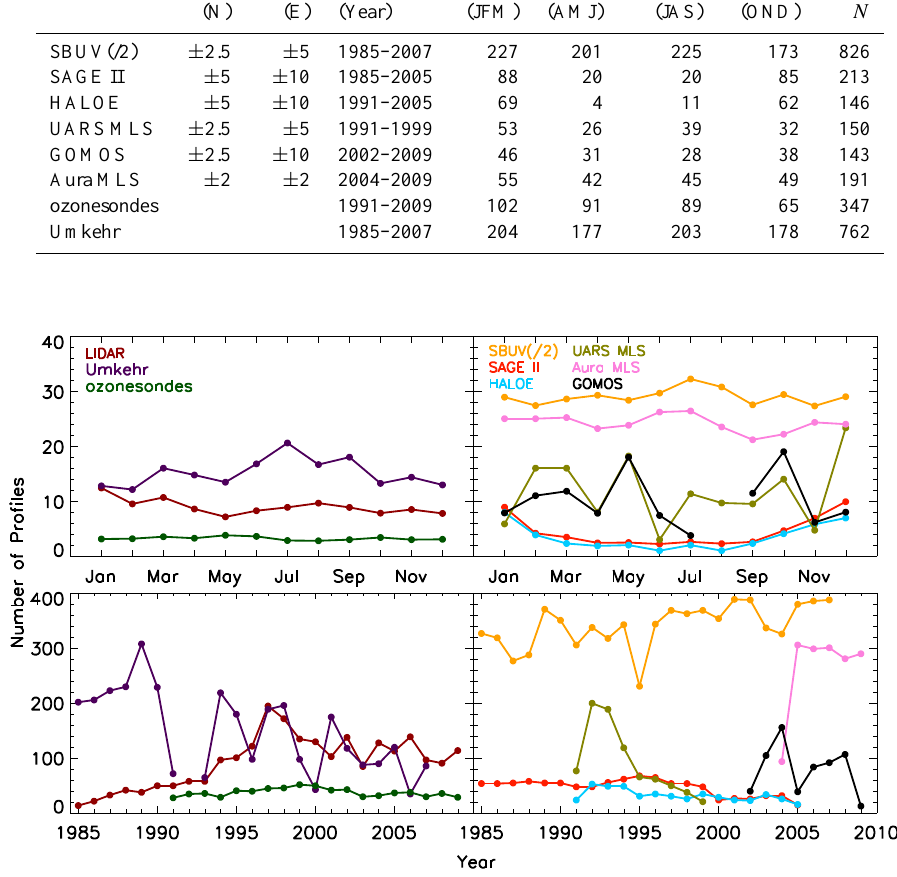
Fig. 1. Average number of observations in each month over the respective period (top panel) and the total number of observations in each year (bottom panel) of various data sets. Left: ground-based measurements at OHP. Right: satellite observations extracted around OHP.